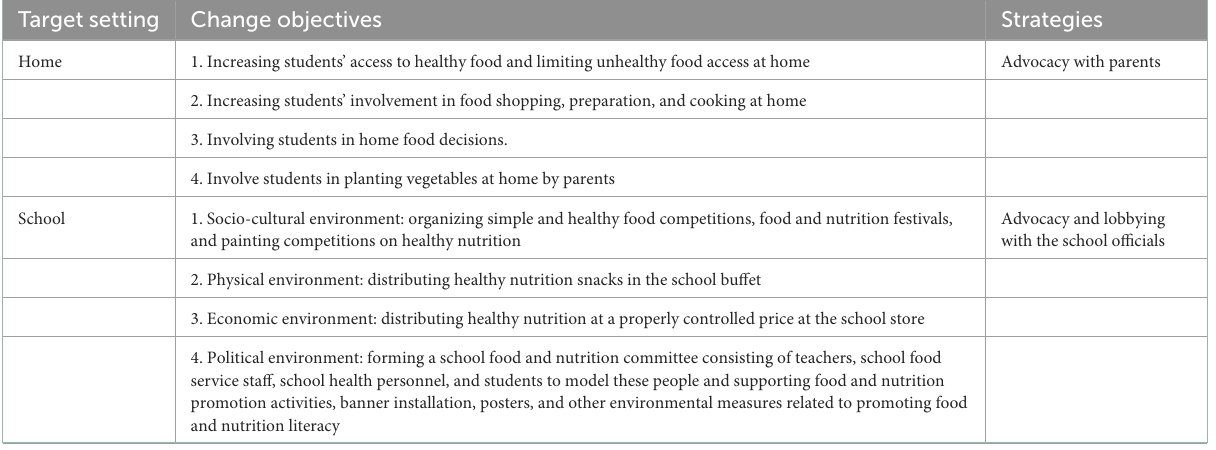
TABLE 2 Environmental changes and the implementation strategies at home and